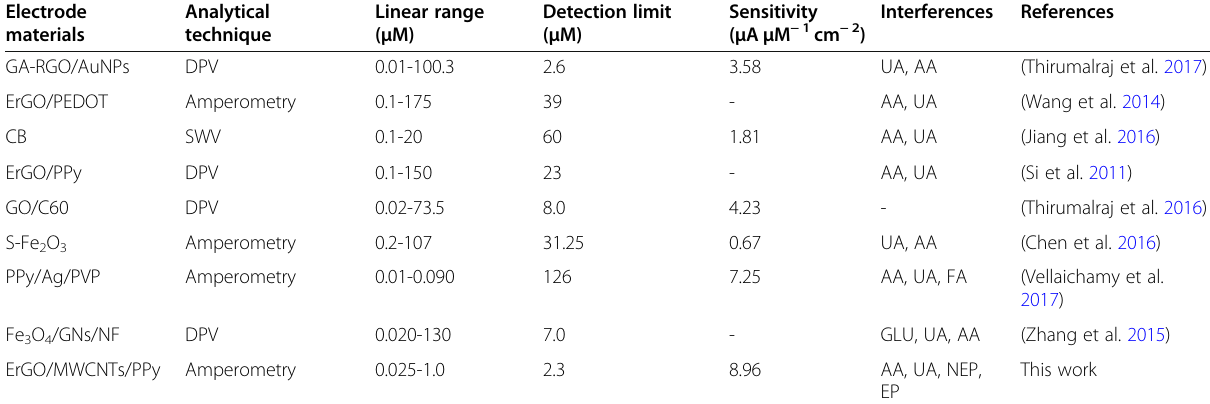
Table 1 Comparison of the electrochemical performance of different electrode materials for DA detection Electrode materials